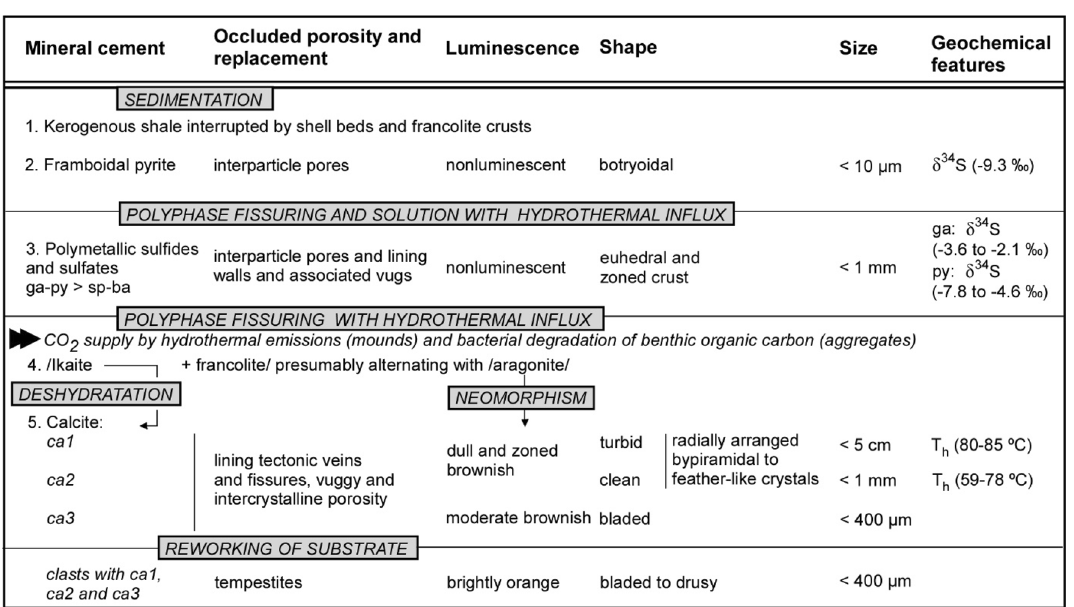
Table 1. Idealized synsedimentary and early-diagenetic succession affecting the carbonate crusts from Öland. ba barite, ca calcite, ga galena, py pyrite, sp